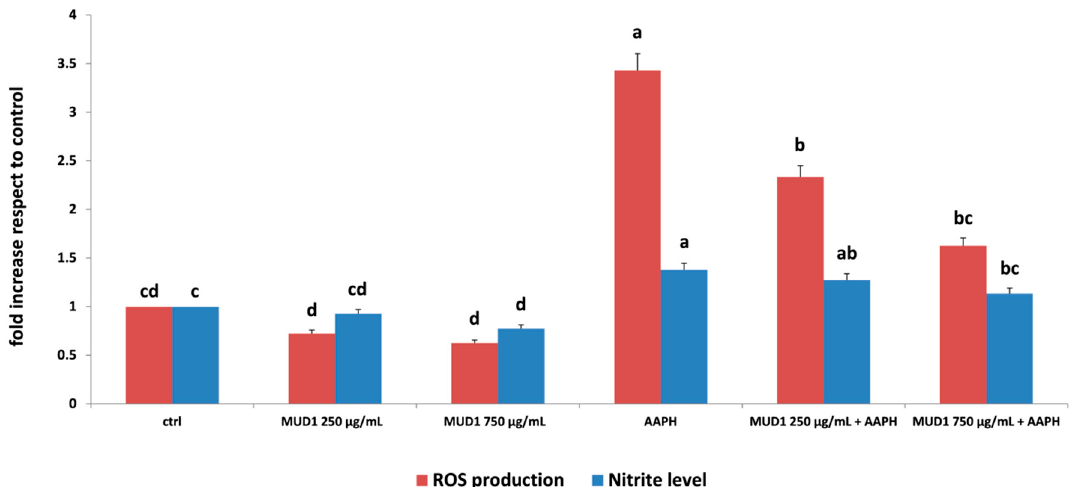
Figure 1. Reactive oxygen species (ROS) production (red bars) and NO 2 − level (blue bars) in human dermal fibroblast (HDF) cells treated with different concentrations of MUD1 (250–750 µg/mL) for 24 h, AAPH (10 mM) for 24 h and with different concentrations of MUD1 and then with AAPH. Data are expressed as mean values ± SD. Columns belonging to the same set of data with different superscript letters are significantly different ( p < 0.05).